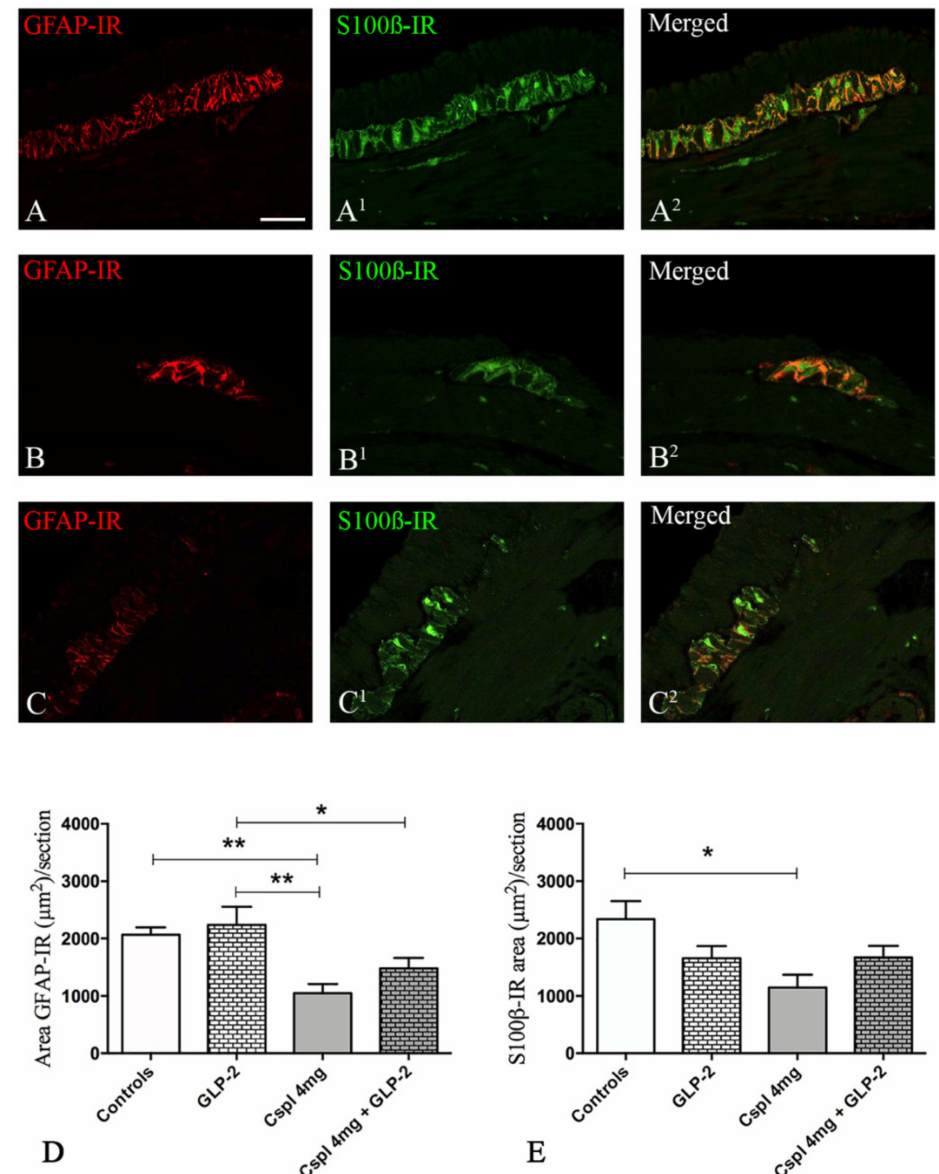
Figure 6. GFAP / S100 β double labeling in the myenteric ganglia. Controls ( A – A 2 ), cisplatin ( B – B 2 ) and cisplatin + [Gly2]GLP-2 ( C – C 2 ) group. GFAP-IR was distributed in the cytoplasm, while S100 β -IR was detected either in the cytoplasm or in the nucleus. Quantitation of GFAP- and S100 β -IR in the myenteric ganglia. The GFAP ( D ) and S100 β ( E ) labeling were measured in well-oriented ganglia, following the criteria described in the Materials and Methods section. Scale bar = 30 µ m. Data are expressed as mean ± SEM. One-way ANOVA test, post hoc Newman Keuls’. ** ( p < 0.01), * ( p < 0.05). n = 4–6 for each